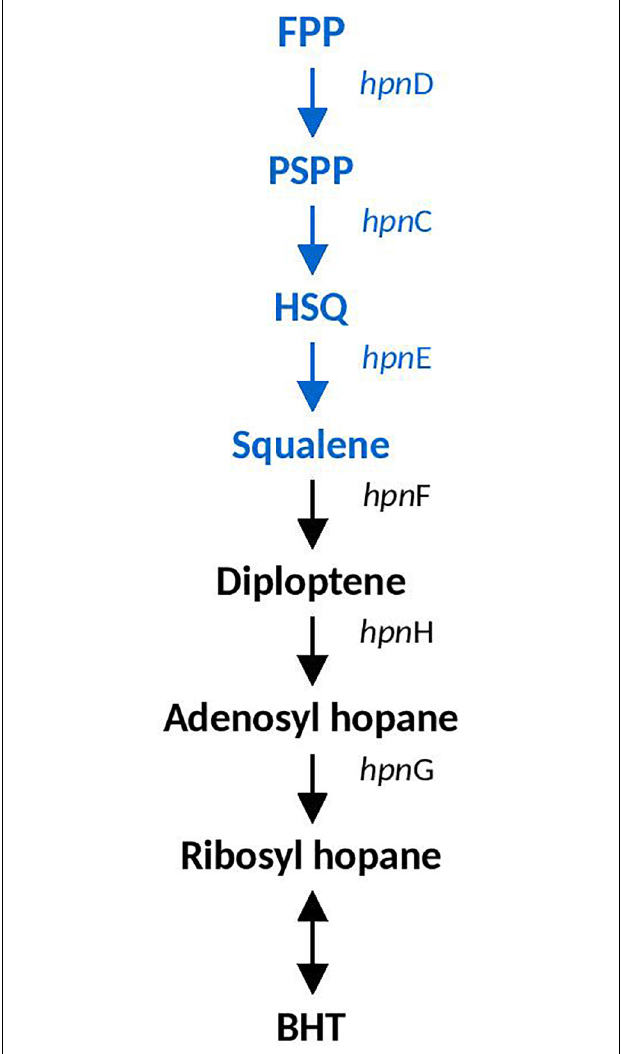
FIGURE 3 | Hopanoid biosynthesis pathway identified in Acidihalobacter. Blue text indicates pathway identified in all Acidihalobacter genomes, black text indicates hopanoid biosynthesis pathway found in A. ferrooxydans. HSQ, hydroxysqualene; BHT,